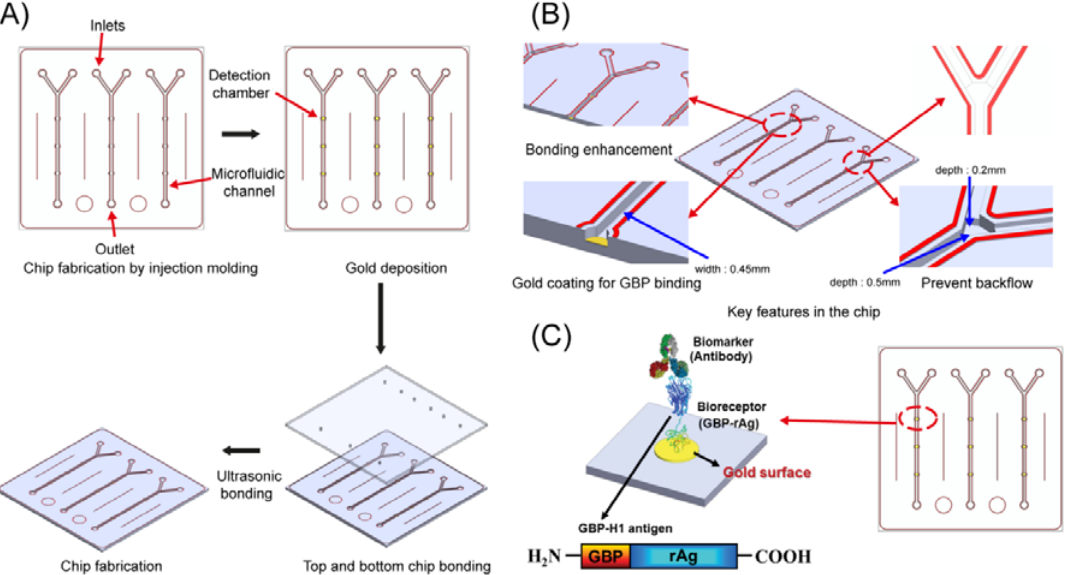
Figure 1. Schematic illustration for ( A ) the fabrication of COC-based microfluidic chip, ( B ) detailed features of the chip, ( C ) GBP-H1a fusion protein immobilization step and Cy3-labeled Ab reaction in the